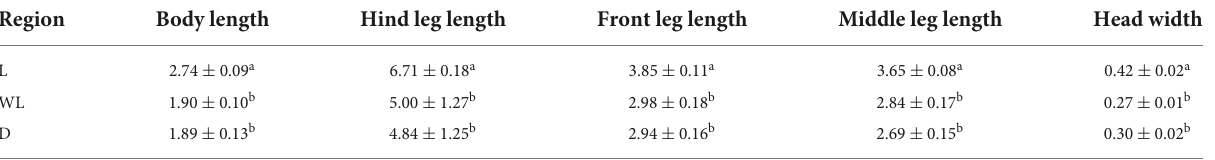
TABLE 1 The morphological traits of Diestrammena japanica in different light-strength regions ( N = 24, Unit: mm). Region Body length Hind leg length Front leg length Middle leg